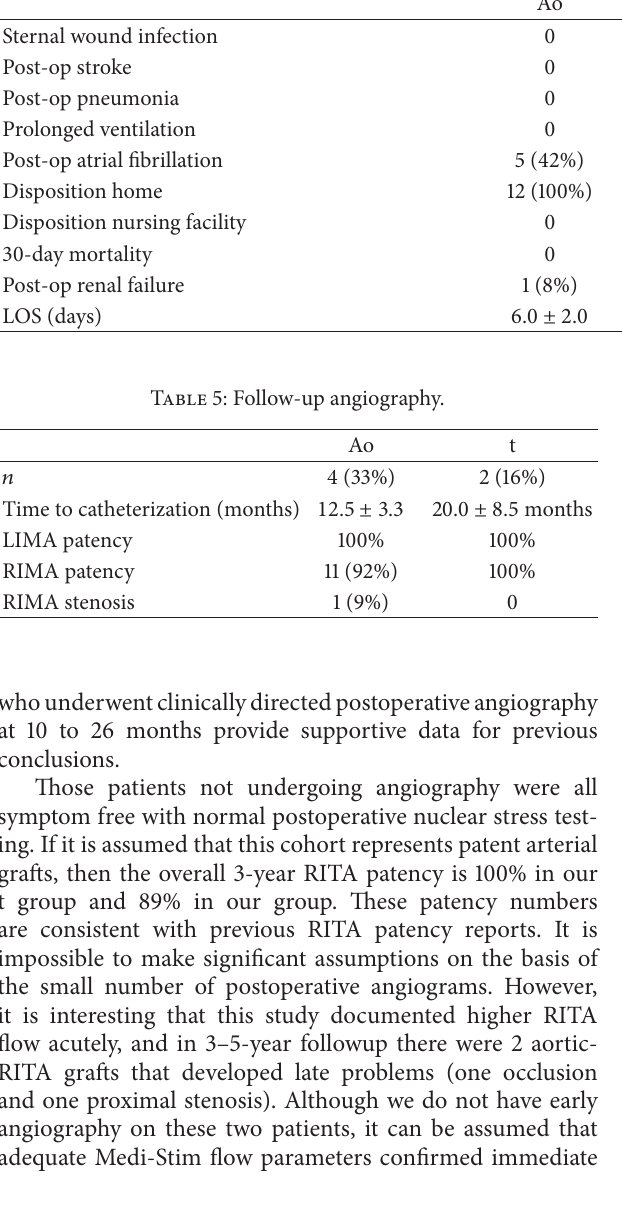
Table 4: Postoperative outcomes.